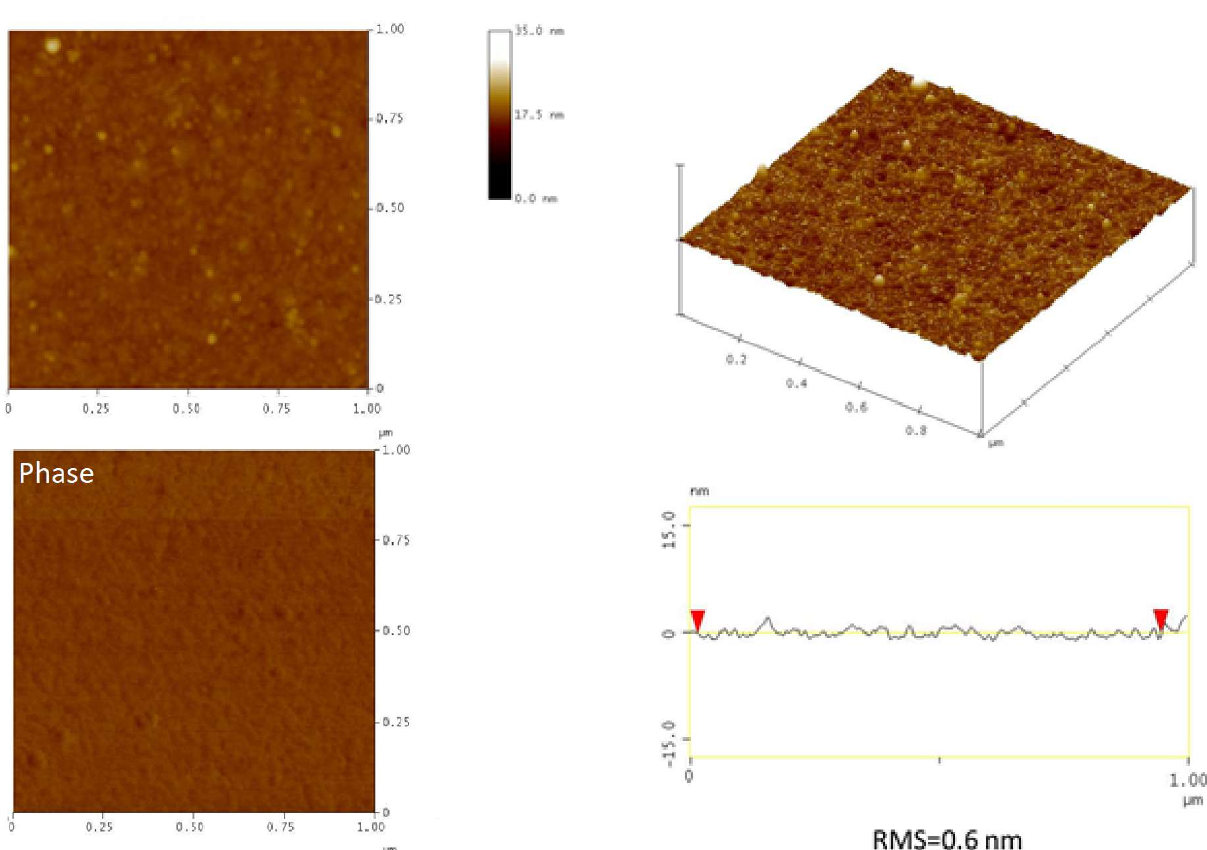
Figure 5. AFM images of P(DMAEMA-co-OEGMA-OH) star layers (sample SC-L).